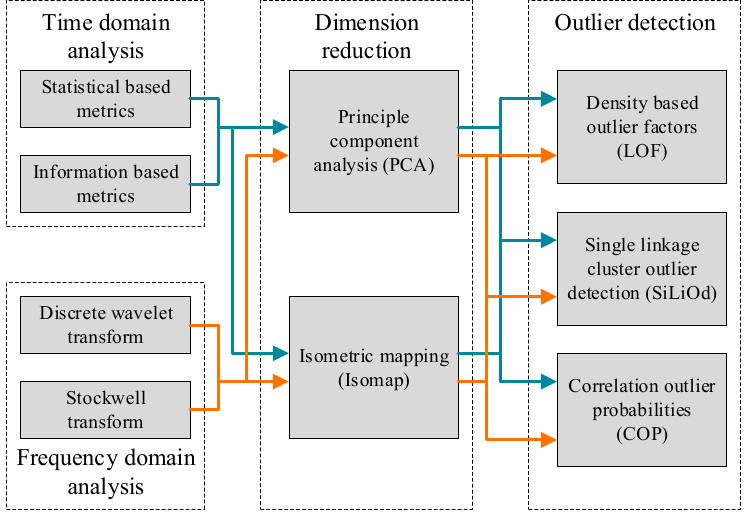
Table 2. Overview of the outlier detection techniques and outlier score properties.